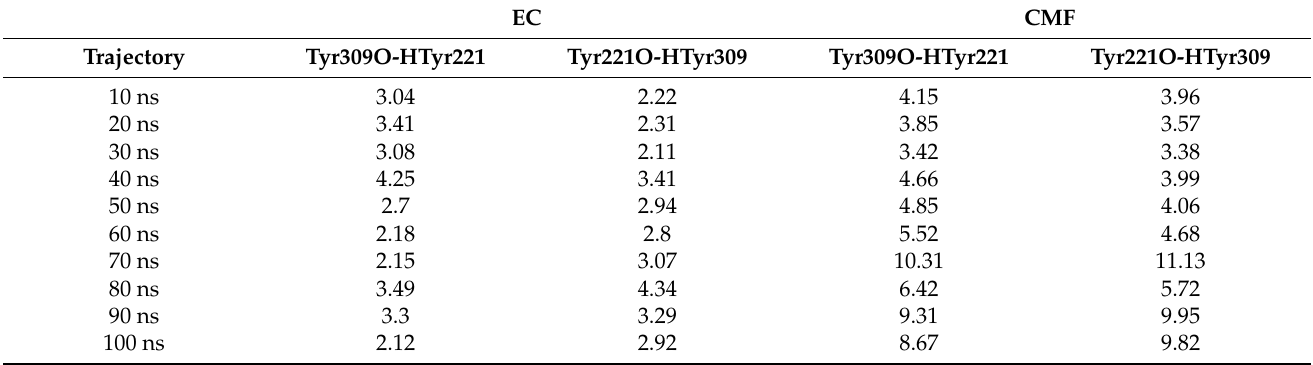
Table 5. Distances in Å (Armstrong) between the TM5 Y221 residue and the TM7 Y309 residue throughout all the aAPLNR complex MD simulations. ns = nanoseconds; O = oxygen acceptor; H = hydrogen